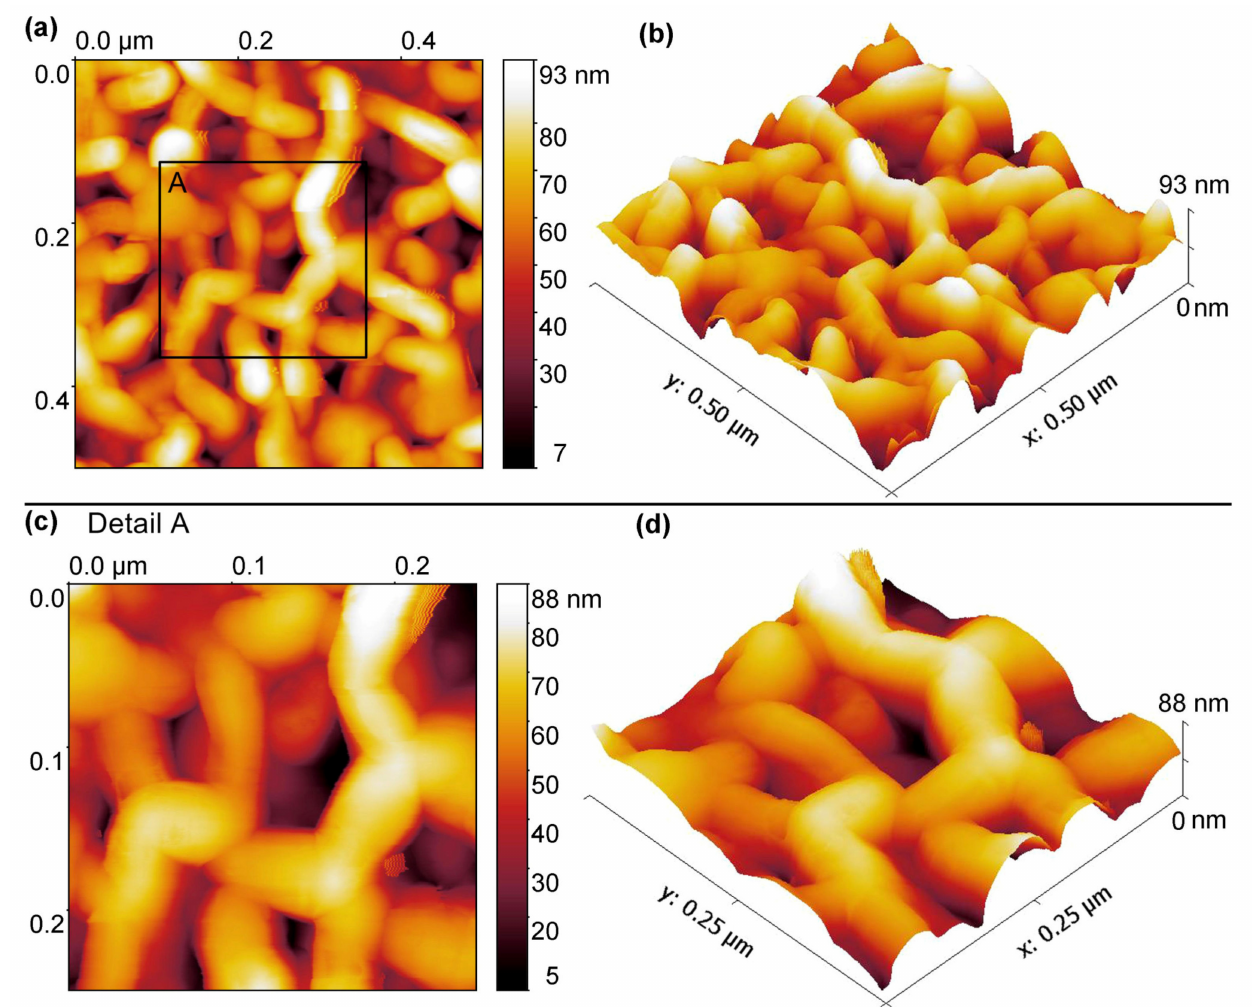
Figure 2. Topography of vertical graphene displayed in 2D and 3D, including a detailed view of the marked area, ( a ) 2D picture, ( b ) 3D picture, ( c ) 2D picture of detail A, ( d ) 3D picture of detail